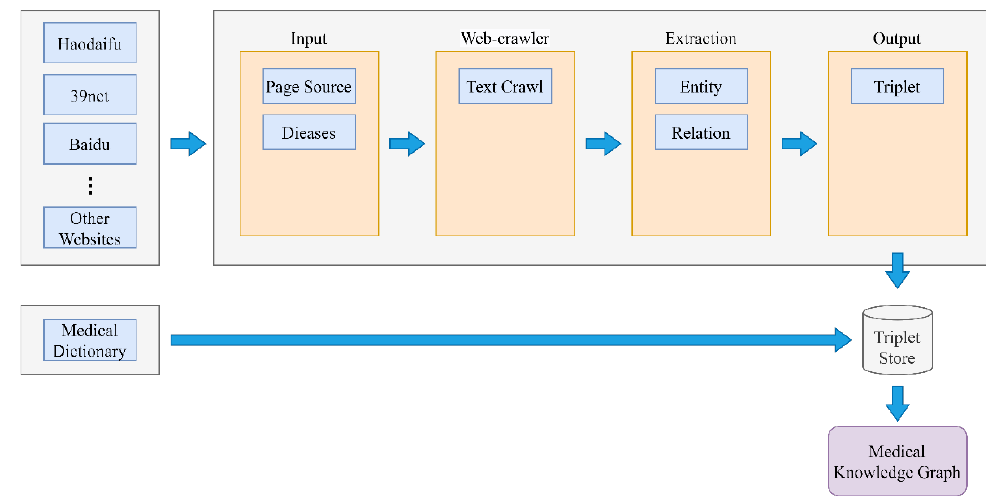
Figure 1. A framework of information extraction in the medical field.